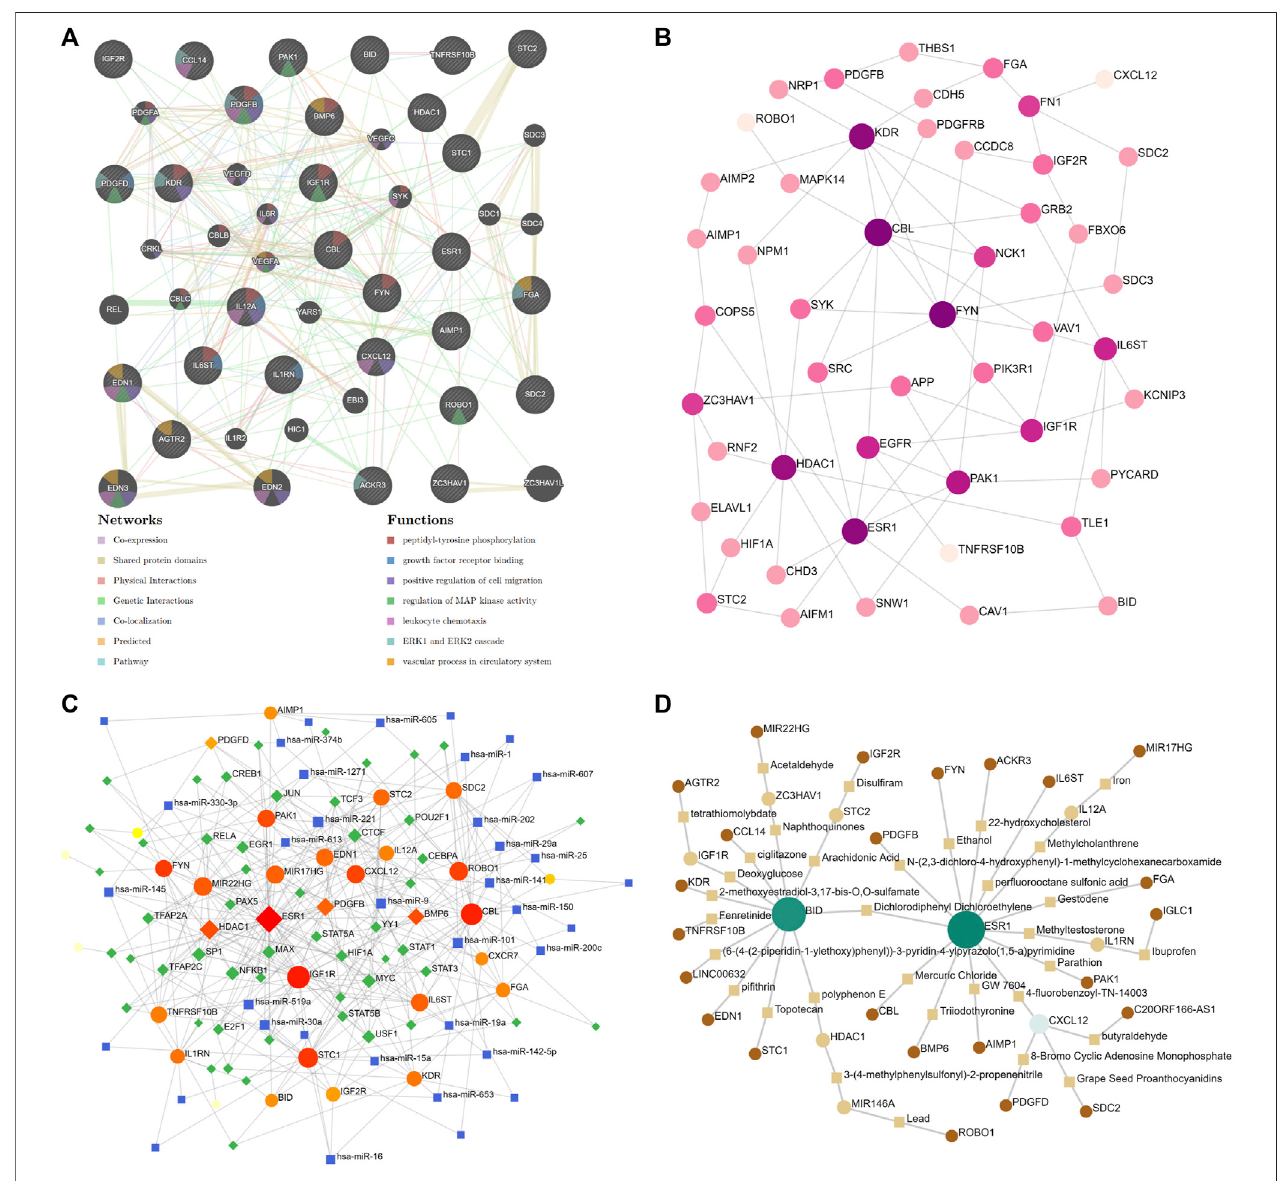
FIGURE 8 | Signi fi cantly ceRNA networks in DCM. (A) 50 most signi fi cant co-expressed of protein-protein interaction (PPI) network by GeneMANIA. (B) heart- speci fi c protein-protein interaction network by NetworkAnalyst. (C) transcription factor-miRNA (TF-miRNA) coregulatory interactions network by NetworkAnalyst. (D) Potential target drugs of sex difference immune-related ceRNA Network by NetworkAnalyst.